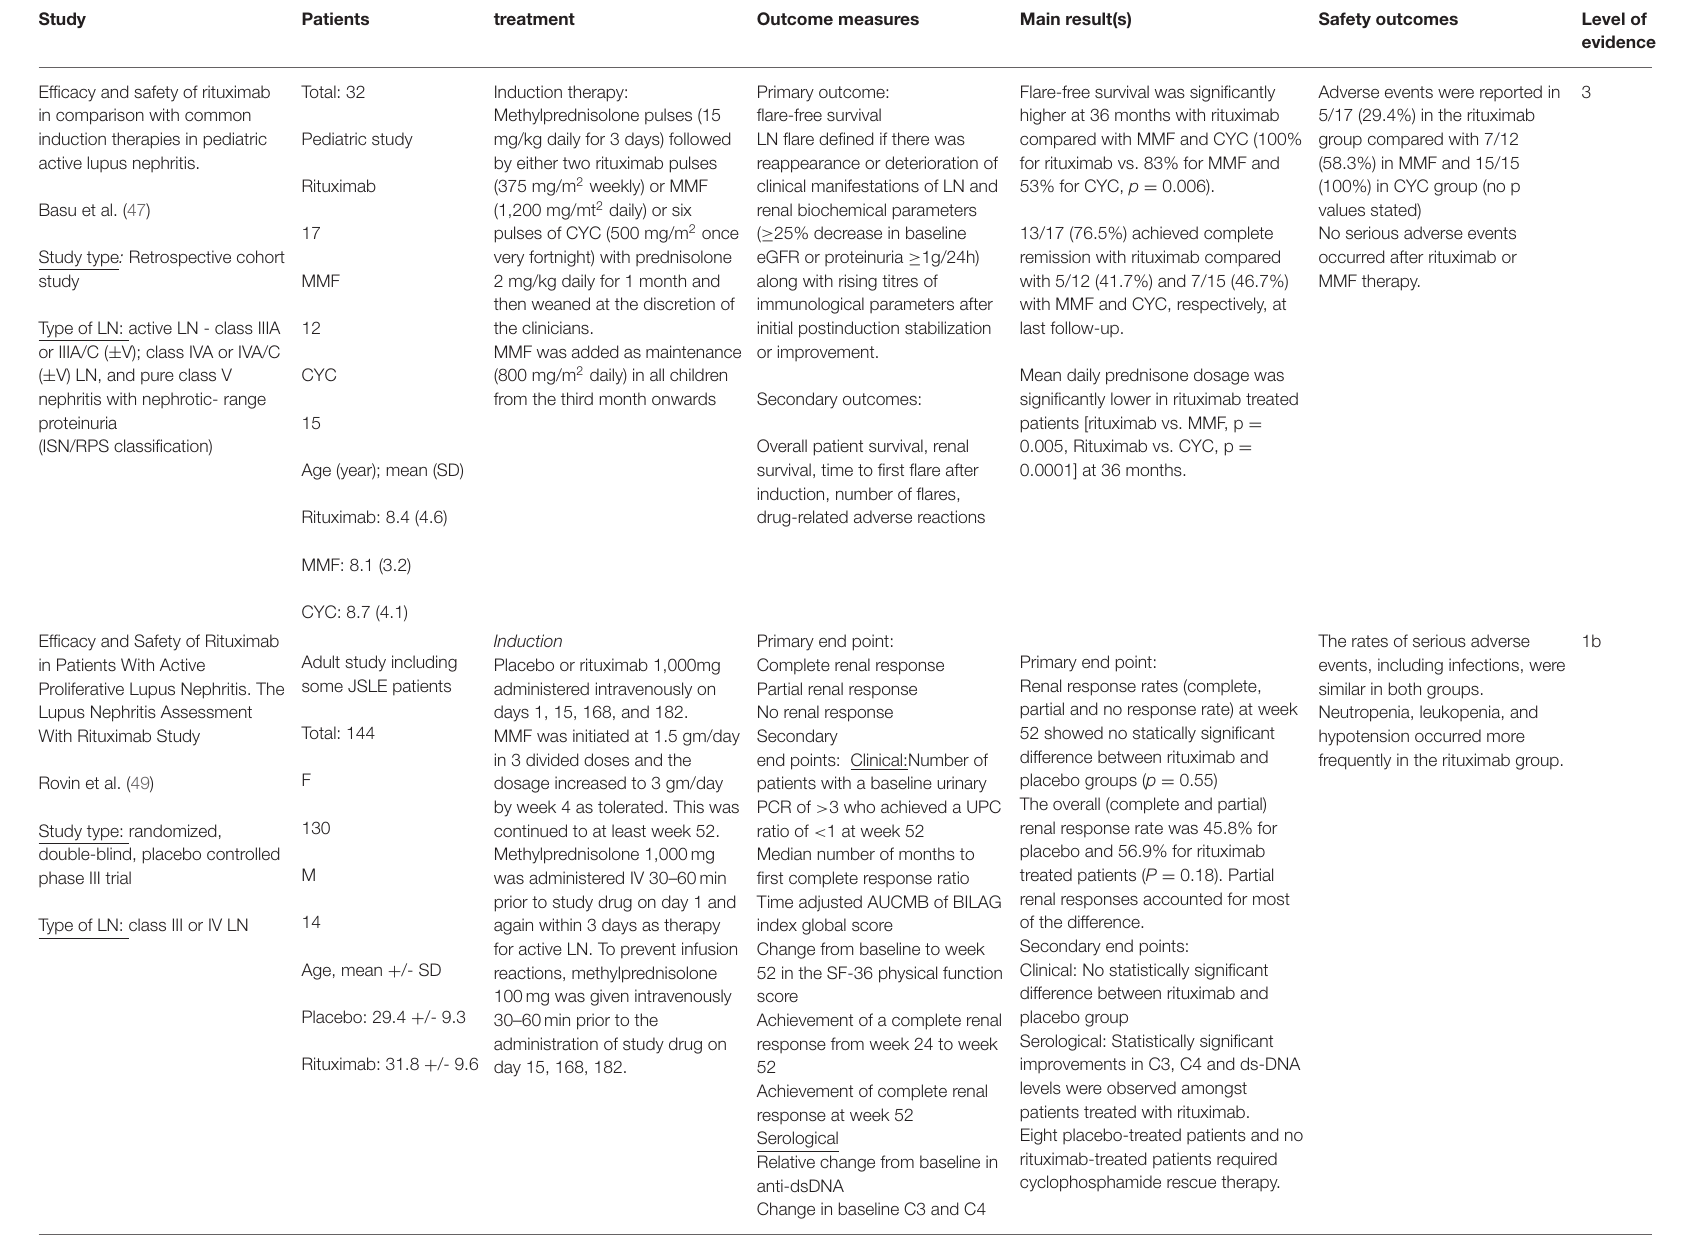
TABLE 3 | Summary of pediatric lupus nephritis treatment studies from 2012 including biologics, disease modifying anti-rheumatic drugs and mesenchymal stem cell